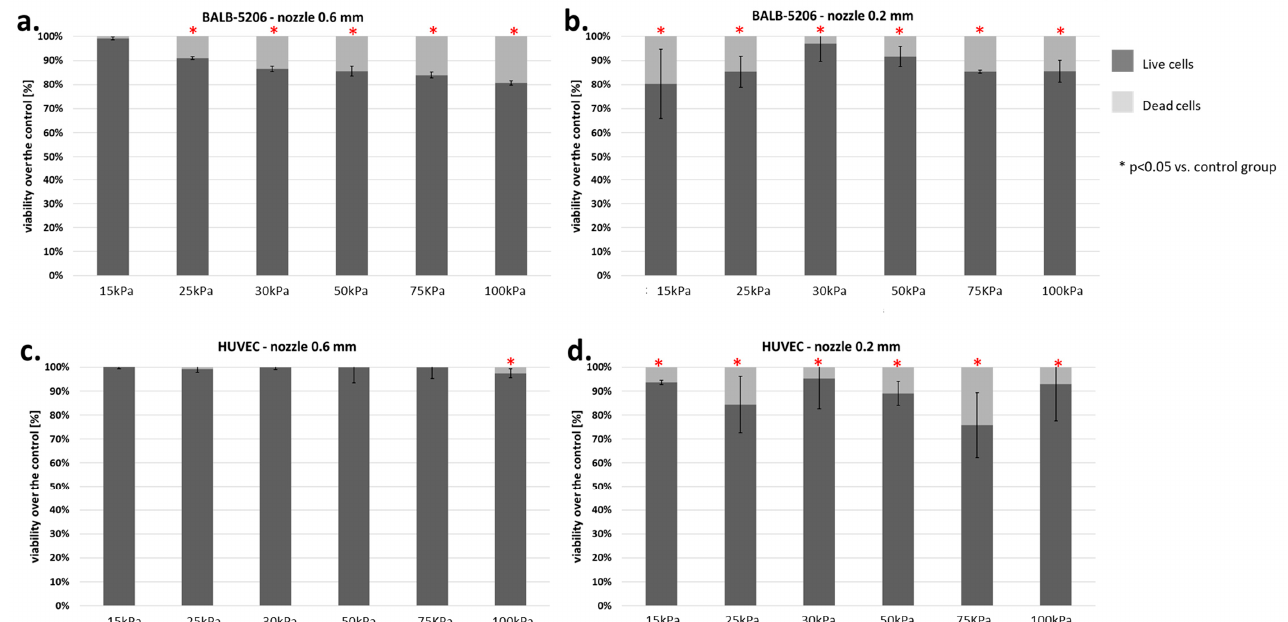
Figure 12. Viability of endothelial cells (BALB-5206 ad HUVEC) subjected to the bioprinting process with different pressures and nozzles with an internal diameter of 0.6 (Figure 8a,c) and 0.2 mm (Figure 8b,d). As a carrier material, 3% ( w/v ) alginate was used, and the vitality of the islets was assessed based on FDA/PI staining and determined in accordance with Equation (7). Our control consisted of cells right after the trypsinization process. The P -value for each pressure was calculated in comparison to the control group. In BALB 5206, P-value was determined using Fisher’s method, and statistical significance ( P < 0.05) was observed in each pressure of 0.2 mm nozzle and in almost even pressure of 0.6 mm nozzle (excluding 15 kPa). In HUVEC, P -value was determined using Fisher’s method, and statistical significance ( P < 0.05) was observed in each pressure of 0.2 mm nozzle and only in 100 kPa of 0.6 mm nozzle. N = 3.